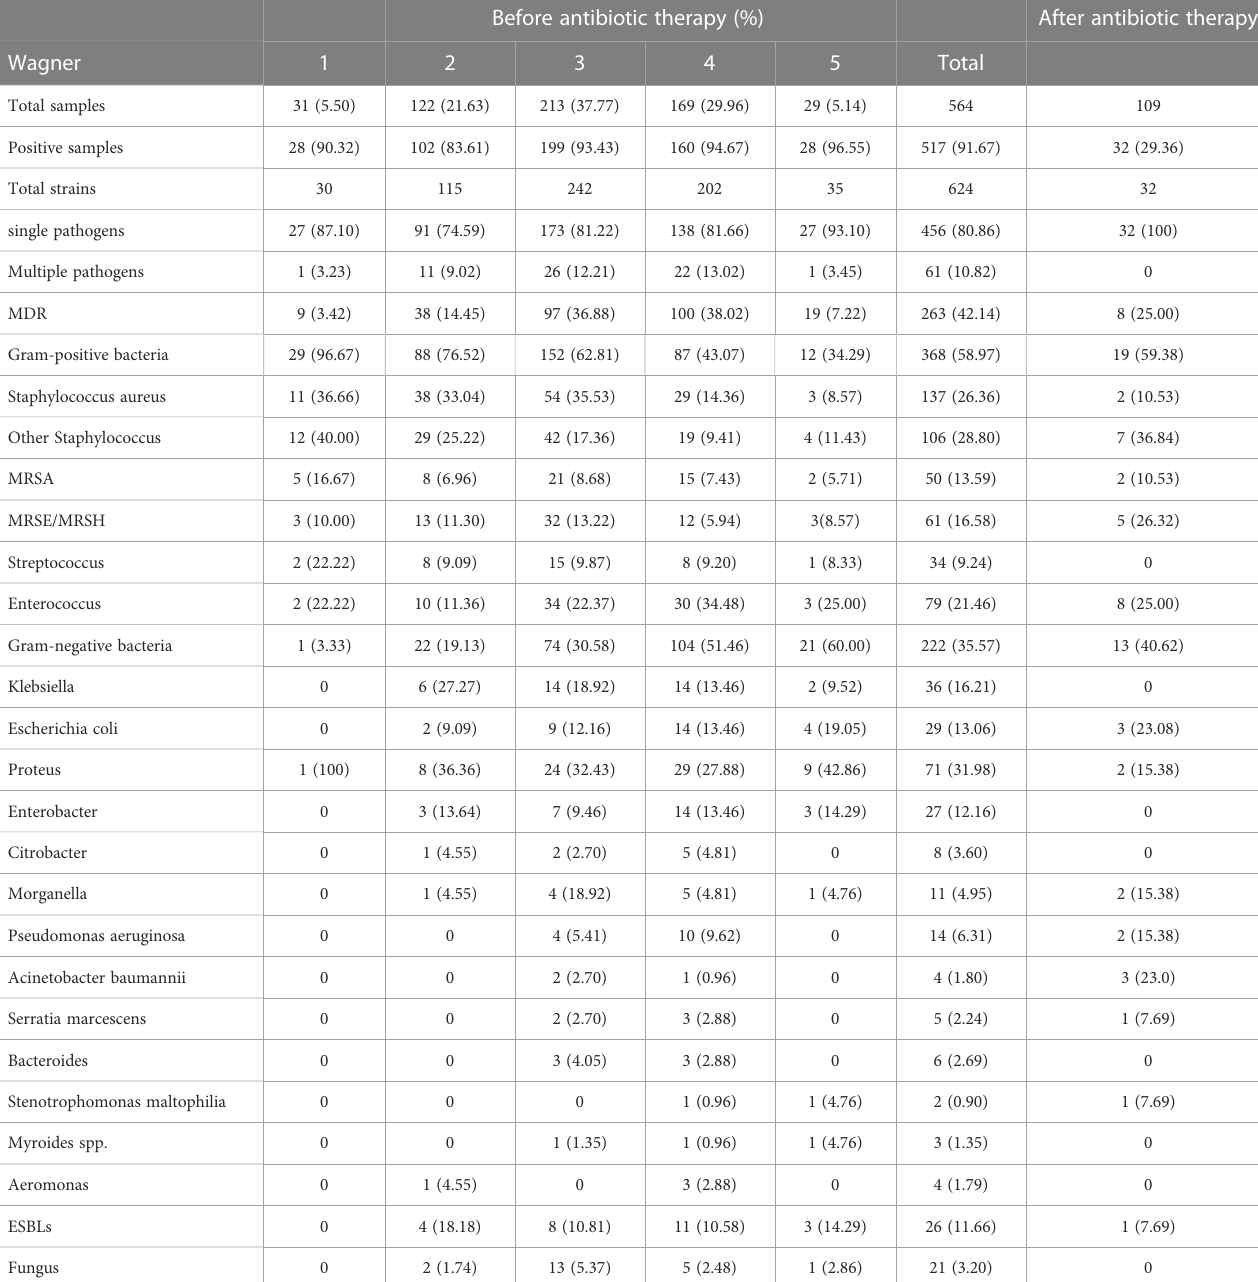
TABLE 2 The distribution of pathogenic bacteria was detected in DFI with different Wagner grades. Before antibiotic therapy (%) After antibiotic